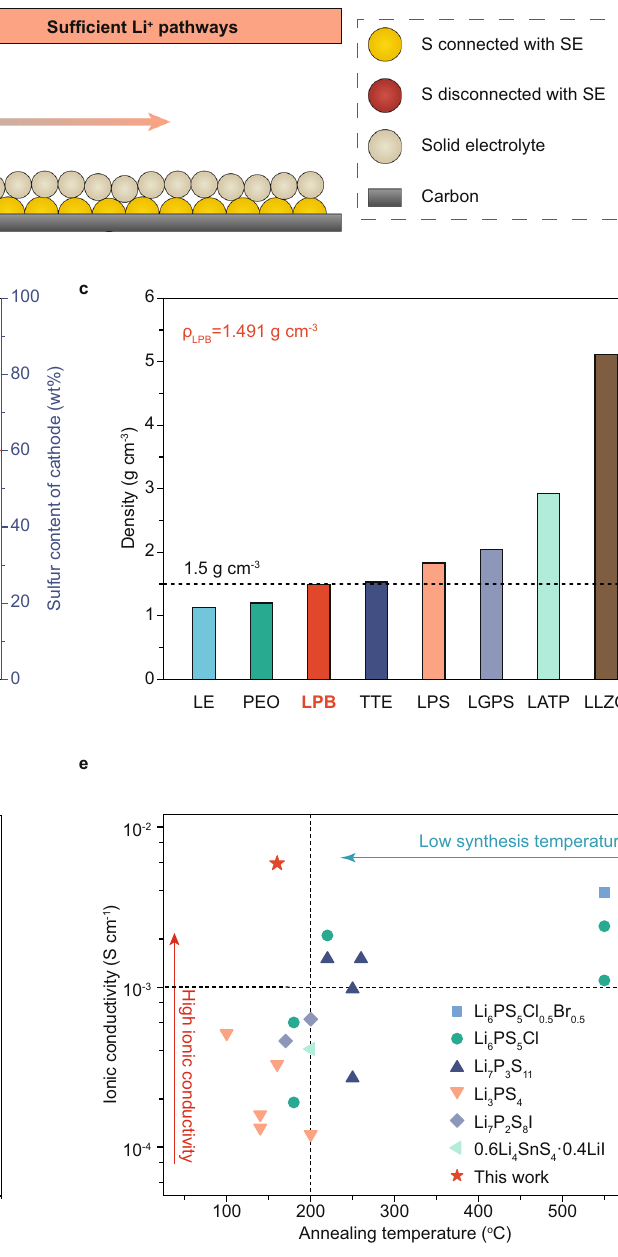
Fig. 1 | PhysicochemicalpropertiesoftheLi 3 PS 4 -2LiBH 4 solid-state electrolyte. a Schematicillustrationshowingthatthesuf fi ciencyofLi + pathwaysincreasesupon increasing SE volume content (from left to right) in the sulfur cathode. b Dependenceofspeci fi cenergyatbatterylevelandsulfurcontentatcathodelevel on the density of SE. The estimation was performed by assuming fi xed volume ratios of cathode (or battery) components. The weight of the sulfur cathode, SE membrane, Li anode, and current collectors was considered for calculating the speci fi c energy of Li-S ASSBs. c Comparison of density among LPB, non-aqueous liquid electrolyte solutions, polymer electrolytes, and inorganic SEs. LE: non-